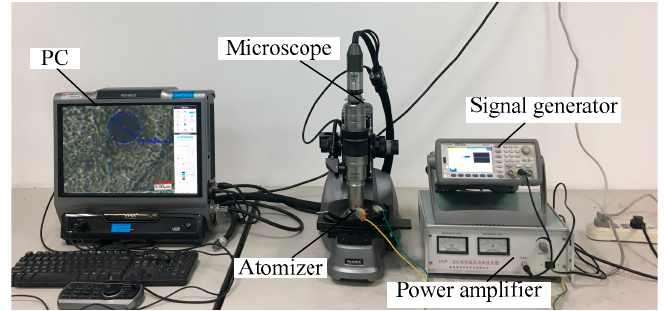
Figure 9. A photograph of how the aperture is measured.